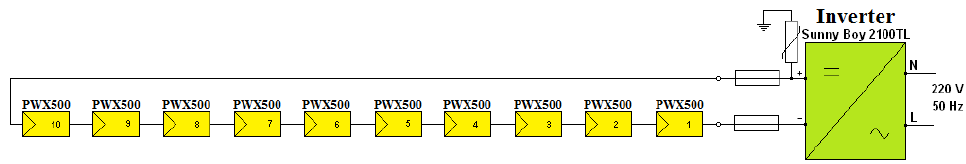
Figure 3. Block diagram of the 10 photovoltaic panels connected to the local power network. Figure 2. The developed hardware infrastructure—pilot microgrid. Figure 2. The developed hardware infrastructure—pilot microgrid.